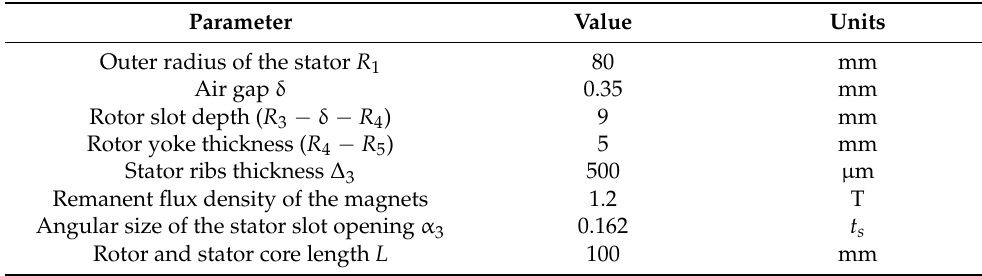
Table 3. Fixed parameters of the PMFSG. t s : the angular tooth pitch of the stator. Parameter